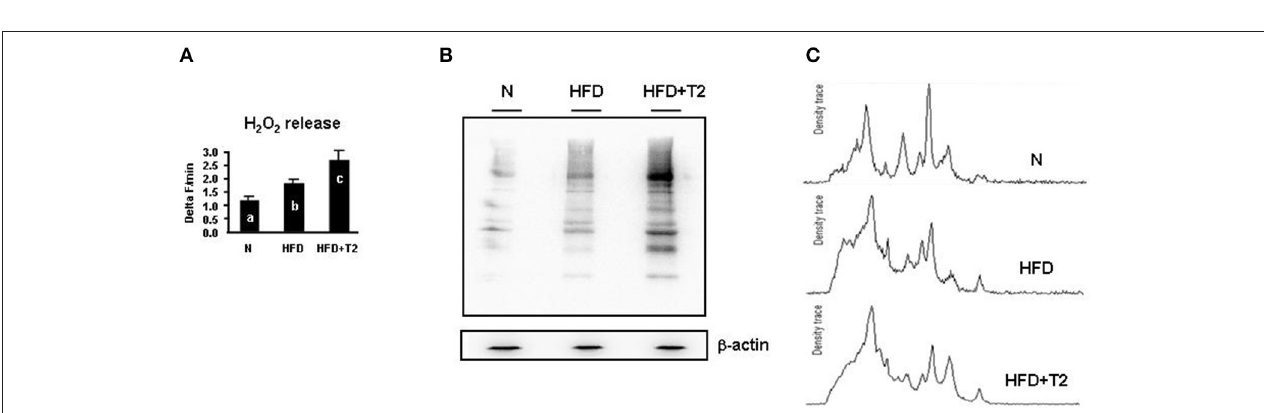
FIGURE 5 | Effects of HFD and T2-treatment on mitochondrial H 2 O 2 release and protein carbonylation. (A) Mitochondrial H 2 O 2 release (Delta F/min) in gastrocnemius muscle mitochondria of N, HFD and HFD + T2 rats. Bars labeled with dissimilar letters are significantly different ( P < 0.05). (B) Representative immunoblot showing protein carbonylation in gastrocnemius muscle of N, HFD, and HFD + T2 rats. (C) Representative density traces for carbonylated protein bands are also